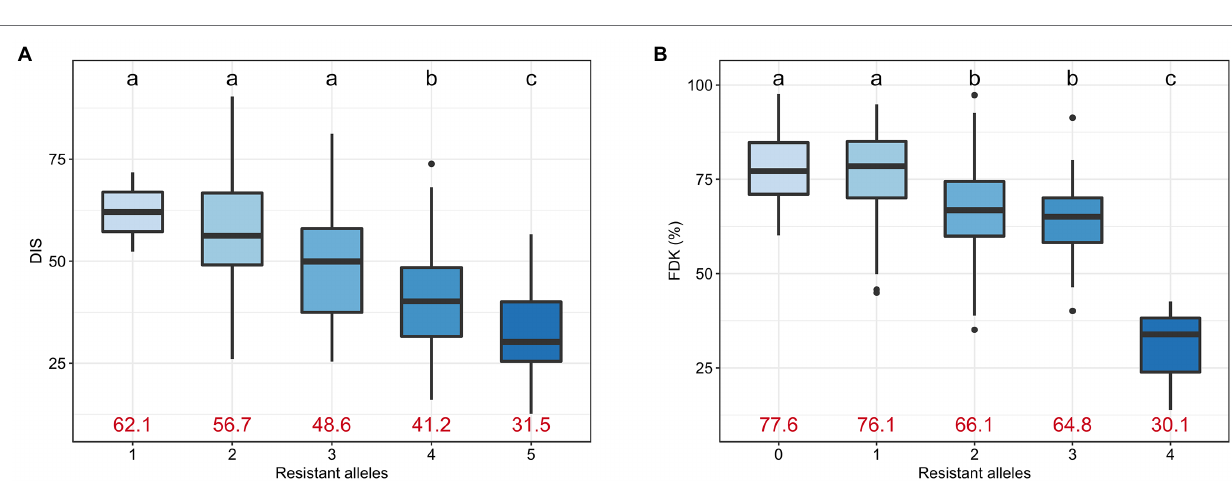
( Supplementary Table S4 ). Further analysis using the wheat expression browser 3 with Fusarium specific studies, and comparison